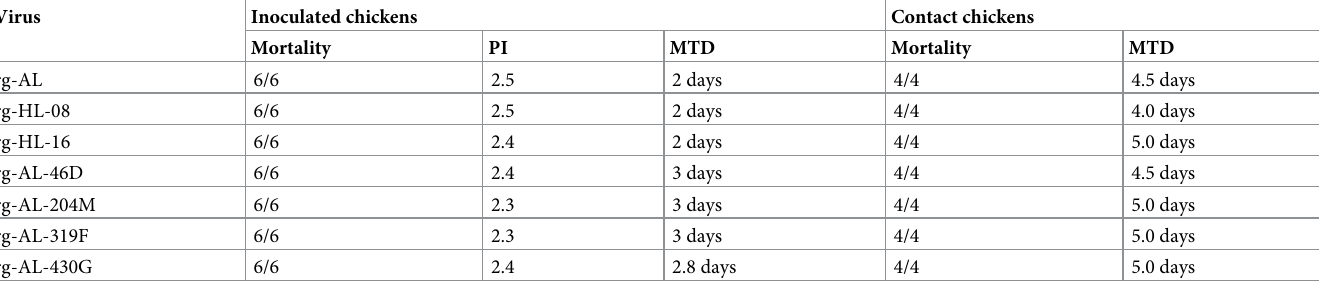
Chickens were inoculated intranasal with 10 4 PFU/bird and one-day post infection (dpi) na ï ve chickens were added to each group to assess virus transmission. PI = pathogenicity index; it was calculated as mean value of daily clinical scoring of animals as 0 (healthy), 1 (showing one clinical sign: depression, cyanosis of shanks, comb and wattles, respiratory distress, diarrhoea), 2 (showing two clinical signs) and 3 (dead) for 10 days according to the OIE guidelines. MTD = mean time to death (days after